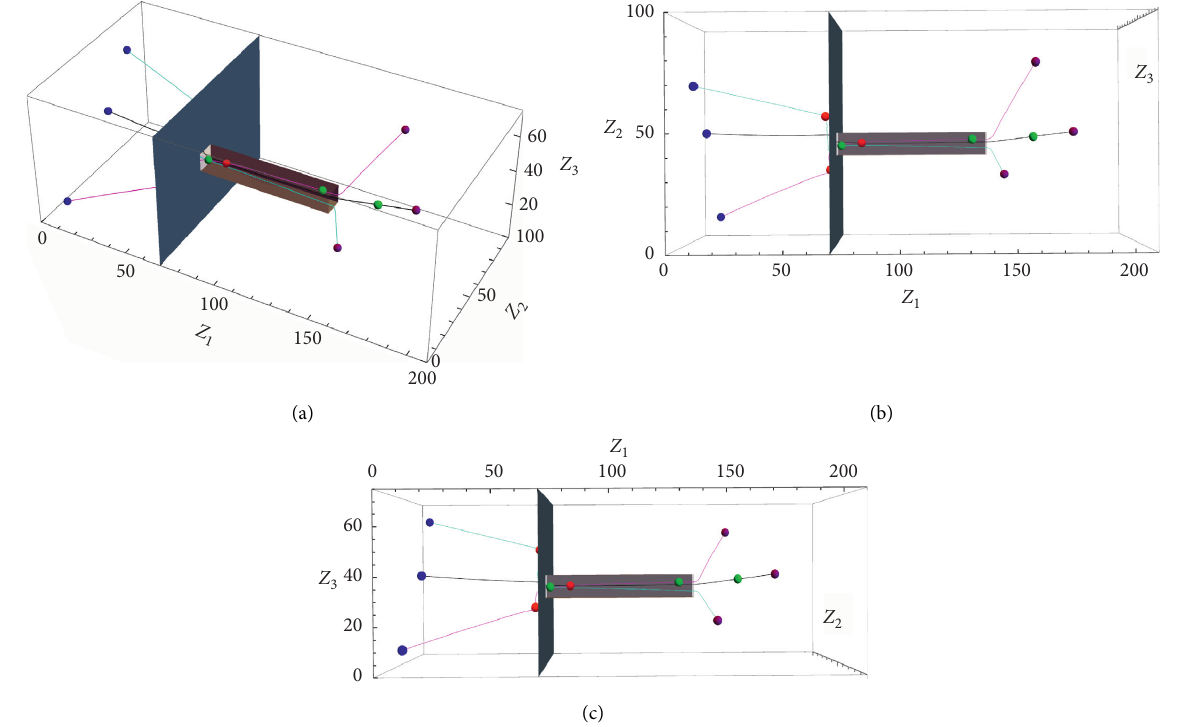
Figure 9: Scenario 3. The evolutionary behavior of the Lyapunov function, its time derivative, and its control inputs along the trajectories of Figure 10. (a) Lyapunov function. (b) Lyapunov function time derivative. (c) Controllers.